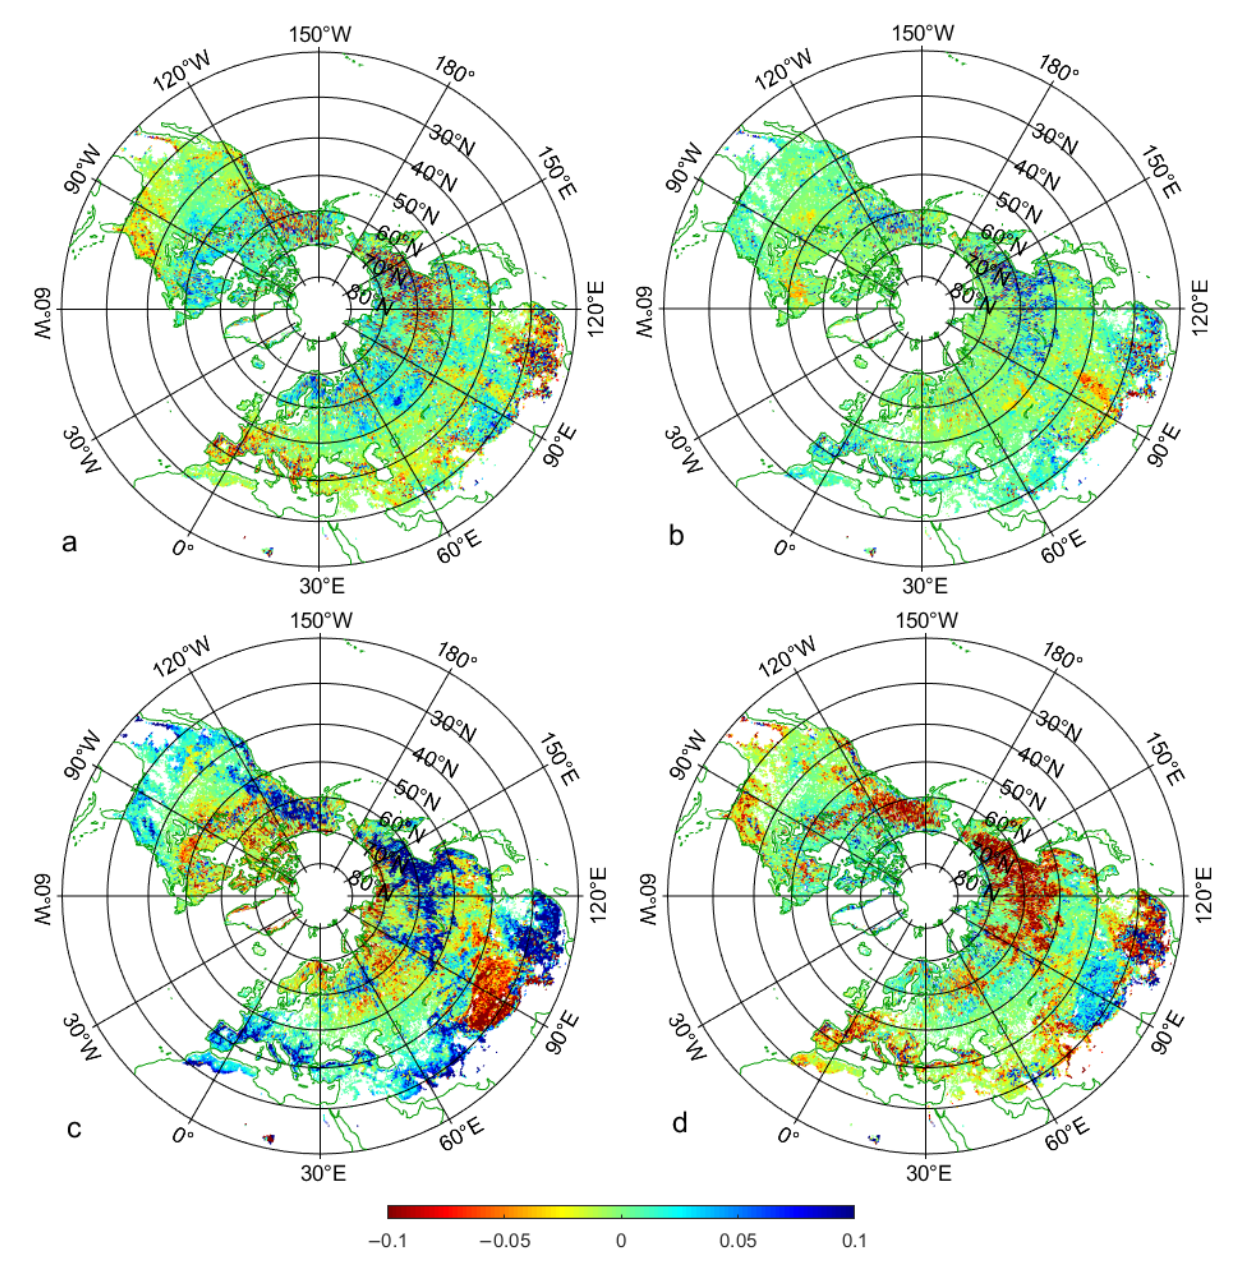
Figure 12. The spatial pattern of the fraction of agreement difference compared to Figure 9b for β = 3 ( a ), β = 11 ( b ), γ = 5 ( c ), and γ = 11 ( d ).